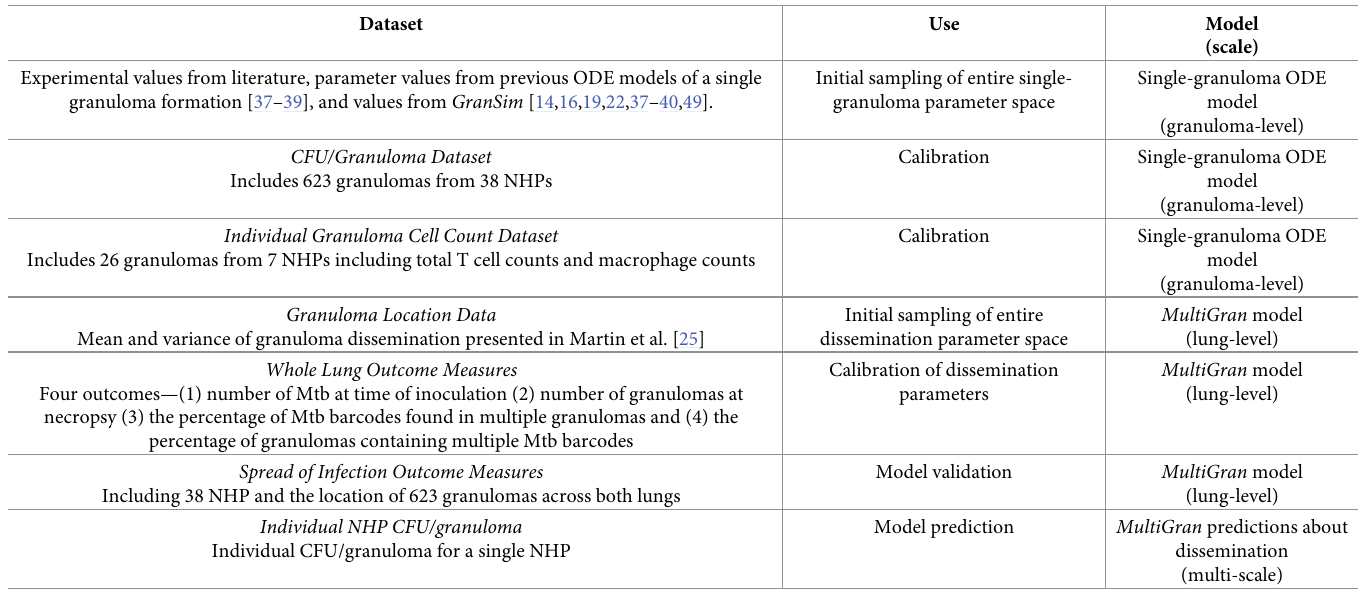
Table 1. Distinct datasets used to calibrate, validate and inform prediction-making in MultiGran . We calibrated our single-granuloma model, and then calibrated parameters specific for dissemination at the whole-lung level, prior to validation and predictions of individual NHP